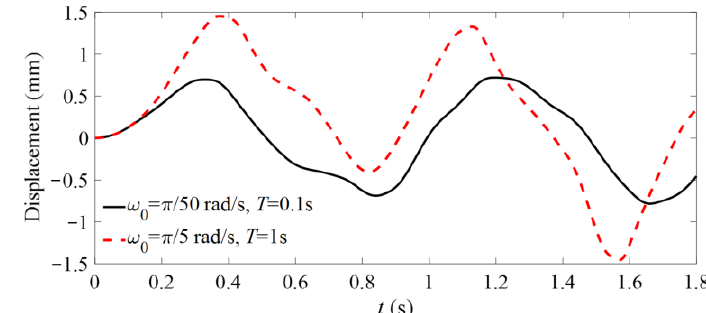
Figure 11. Time histories of point A of M1 with the same acceleration.